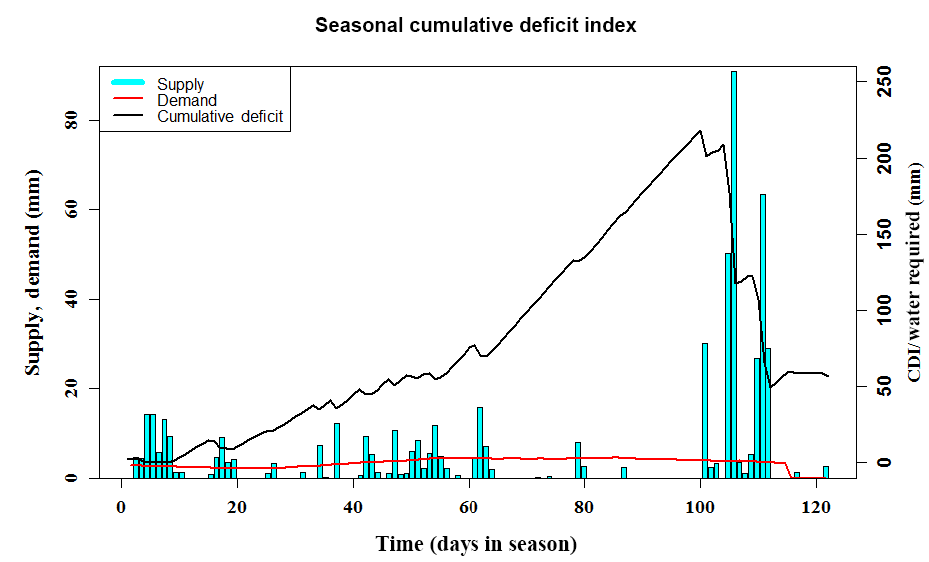
Figure 1. A plot of the cumulative deficit index (CDI) for the JJAS season in a randomly selected year in our data set. The plot depicts the change in CDI as rainfall distribution, and crop water requirement varies over the given monsoon season. The vertical cyan bars are the daily rainfall magnitudes, the slowly changing red line is the crop water requirement (demand) and the black time series is the CDI itself. Notice how CDI increases as rainfall is either low in magnitude or sparsely distributed in certain periods of time in the season.